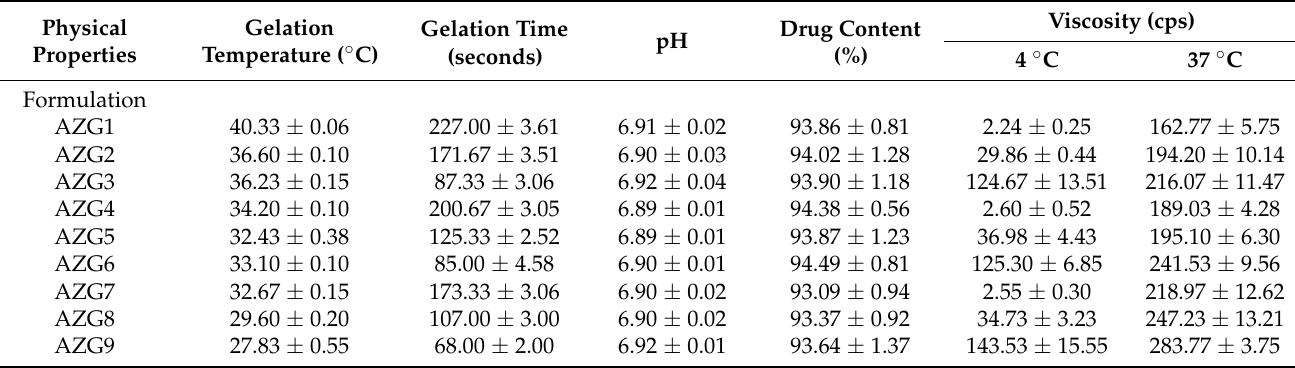
Table 2. Physicochemical properties of AZG formulations (mean ± SD, n =